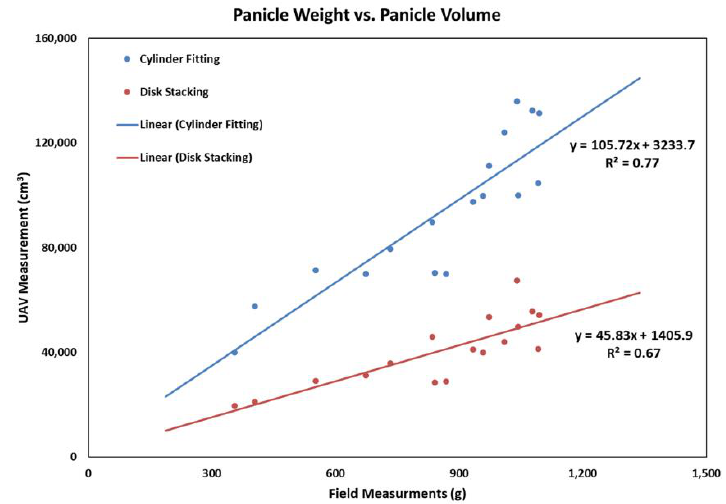
Figure 7. Relationships for ground-measured panicle weight versus panicle volume of selected varieties obtained by cylinder fitting (blue) and disk stacking (red); scattered points were fitted using a linear regression model.